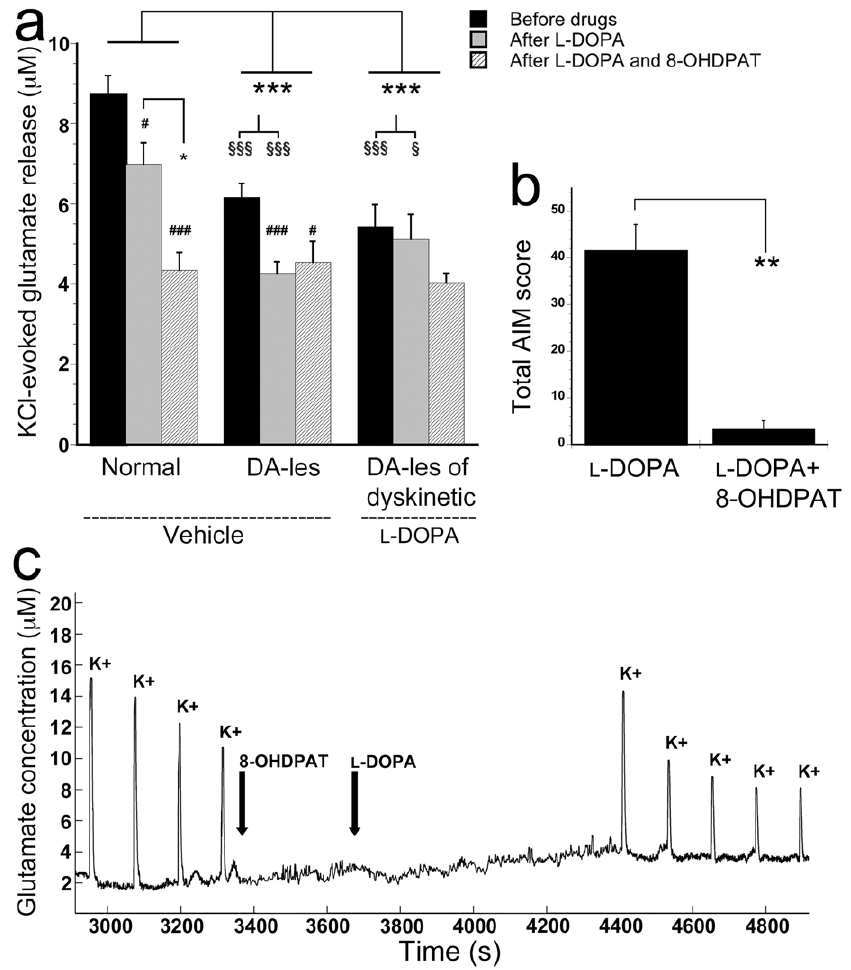
Figure 3. The effects of systemically administered 8-OHDPAT on KCl-evoked (K + ) glutamate release ( m M) during striatal L -DOPA- loading in normal and dopamine-lesioned striata of vehicle- and L -DOPA-injected animals (a) and on AIM scores in dyskinetic animals (b). 8-OHDPAT, systemically administered 5 min prior to striatal L -DOPA ejection, further reduced glutamate release seen after local L -DOPA application in normal (a, c), but not in dyskinetic animals, even though dyskinetic behavior was attenuated (b) when applying the drugs systemically. # p , 0.05 and ### p , 0.001 compared to before acute L -DOPA administration in the same group of animals. * p , 0.05 and *** p , 0.001 for comparisons between groups with 2-factor ANOVA, within groups with one-way ANOVA, and paired t-test. 1 p , 0.05, 111 p , 0.001 for comparisons between groups with one-way ANOVA. Dopamine-lesioned striata is abbreviated DA-les.